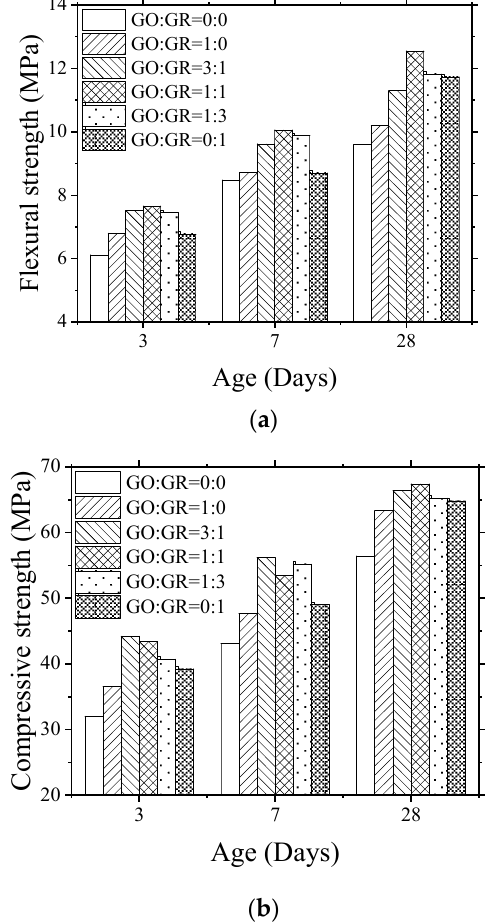
Figure 4. Mechanical properties of cement mortars incorporating GO/GR hybrid with varied ratios. ( a ) Flexural strength; ( b ) Compressive strength.